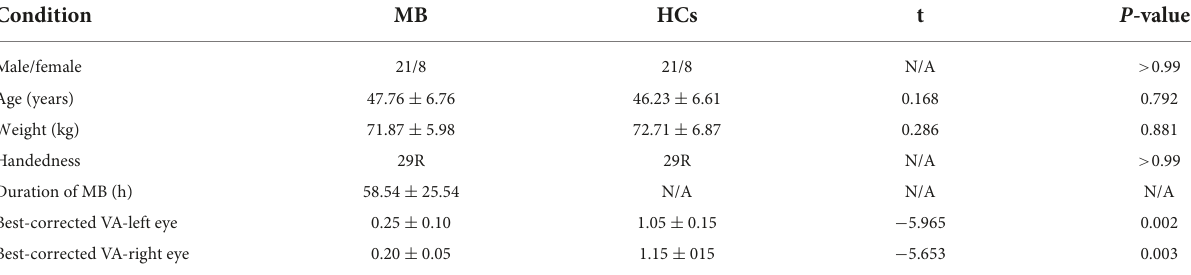
TABLE 1 Characteristics of participants included in the